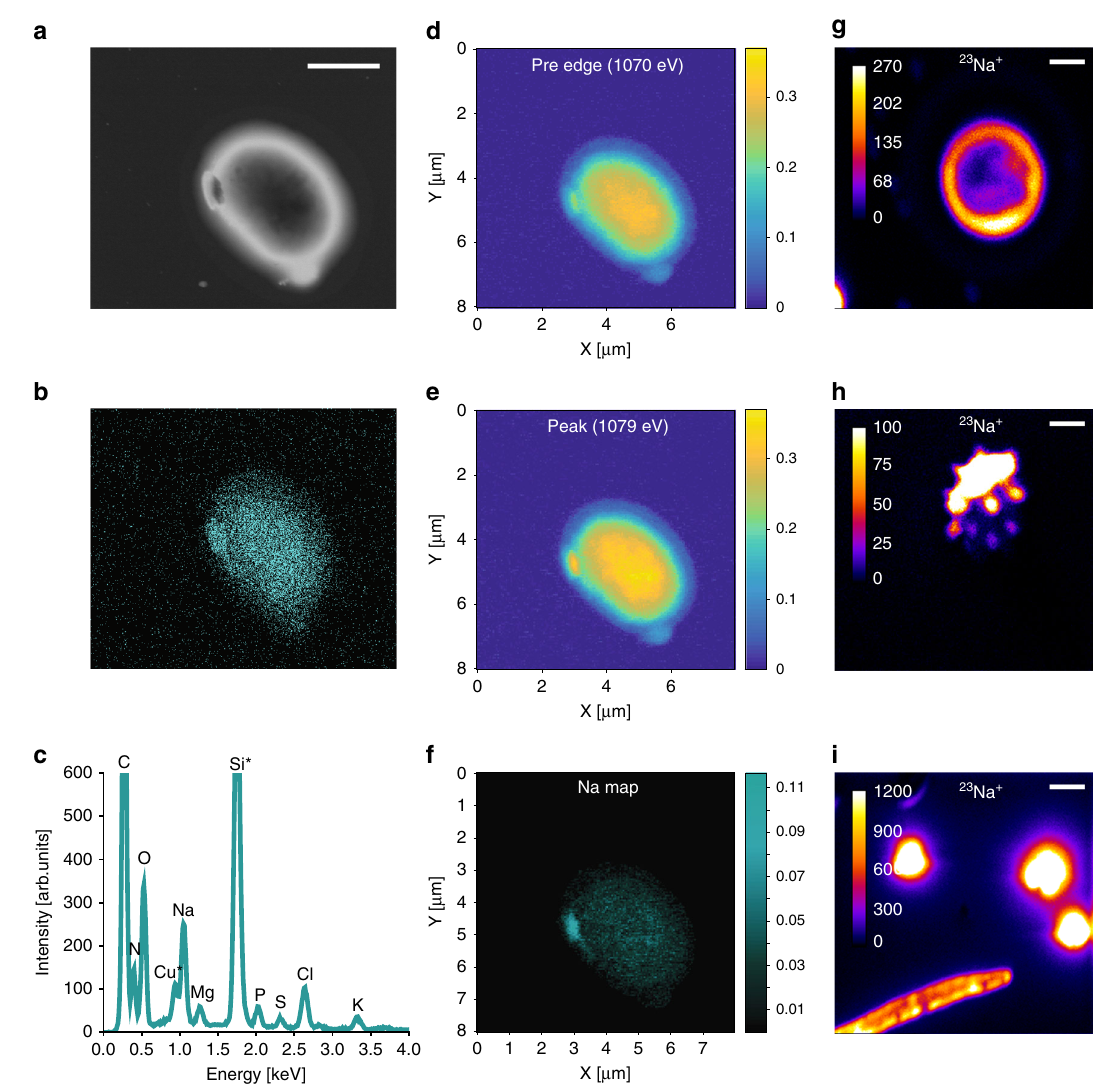
Fig. 2 Chemical imaging of Na-containing biological particles. a SEM image b elemental Na map and c EDX spectra of the biological particle. The Cu and Si in the EDX spectra are background peaks originating from the substrate and various instrument parts inside the SEM chamber. STXM images of the same biological particle: d pre edge (1070eV), e Na peak (1079 eV) and f Na optical density map. Color bars indicate optical density. g – i Representative NanoSIMS images of 23 Na + of selected biological particles showing various distributions of sodium within particles contours. Scale bars are 2 µ